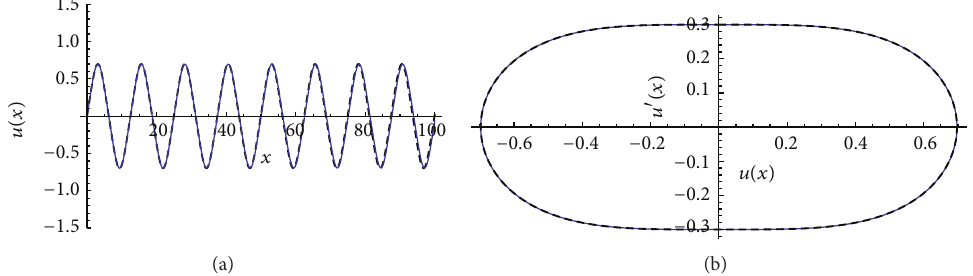
Figure 4: (a) Plots of displacement of 𝑢 versus time. (b) Phase plane diagram of Example 4: solid line the multistep RKHS method and dashed line RK